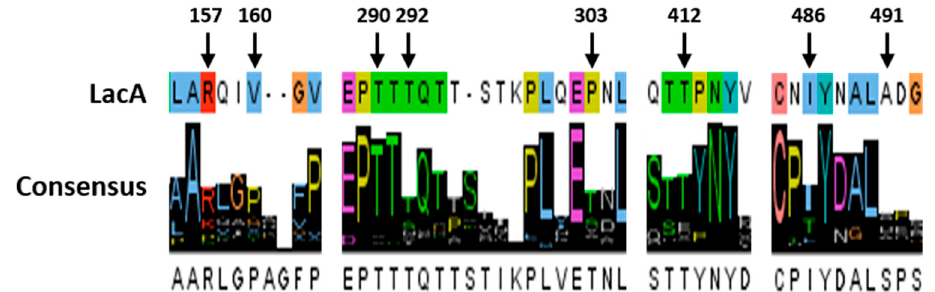
Figure 2. Amino acid consensus results for the alignment of 100 protein sequences with the sequence of LacA. Colors represent different residues generated automatically by the software.